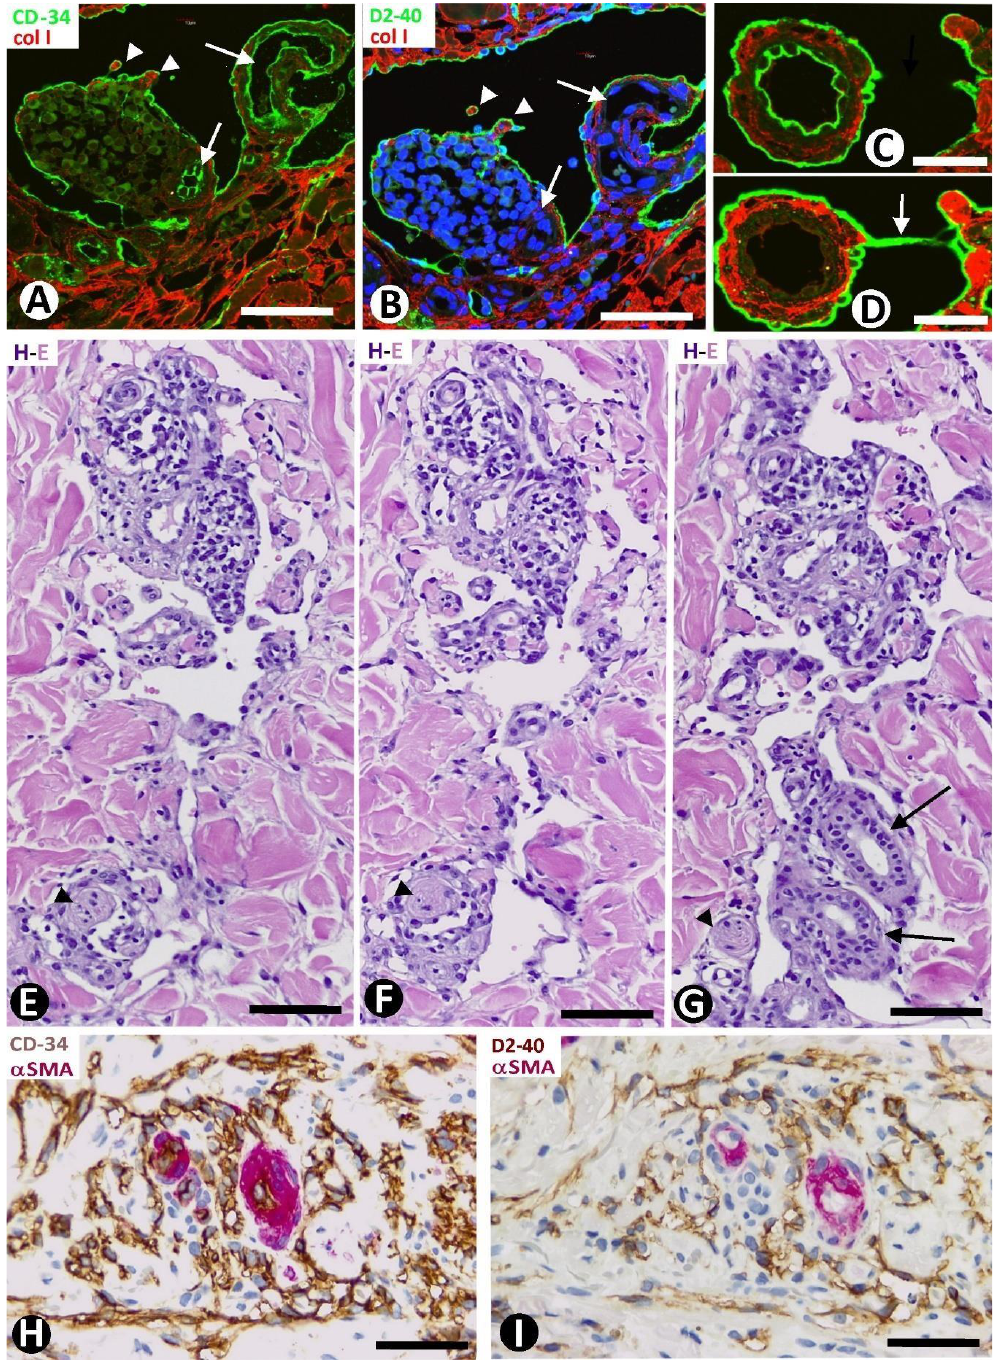
Figure 15. ( A , B ): Two large folds containing pre-existing blood vessels, showing CD34 positivity in ( A ) and negativity for D2-40 in ( B ) (arrows), project into a surrounding wide type 1 neovessel (vessel within vessel: promontory sign). Note the presence of infiltrate inflammation around pre-existing blood vessels, increasing the size of the fold, and two small pillars centered by collagen I forming on the fold surface (arrowheads). ( C , D ): The appearance and disappearance of a pillar observed in two adjacent sections. ( E – G ): A large pathway of type 1 neovessels around blood vessels, glands and a nerve. Note the appearance, disappearance and modifications of some structures in the serial sections. ( H , I ): Elongated type 2 neovessels are seen around pre-existing blood vessels in two of the serial sections, showing small or virtual lumens and expression of markers for ECs of both blood and lymphatic vessels. Double immunofluorescence for CD34 (green) and collagen I (red) in ( A , C ) and for D2-40 (green) and collagen I (red) in ( B , D ). Hematoxylin – eosin staining in ( E – G ).